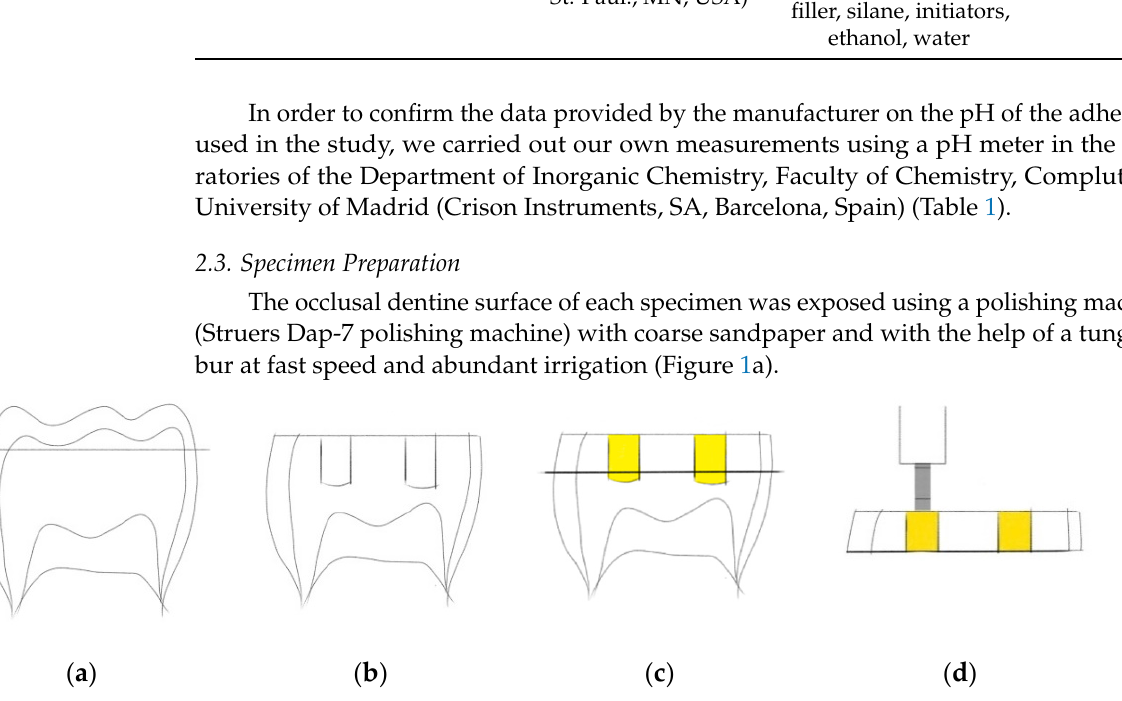
Table 1. Composition and pH of adhesives used.